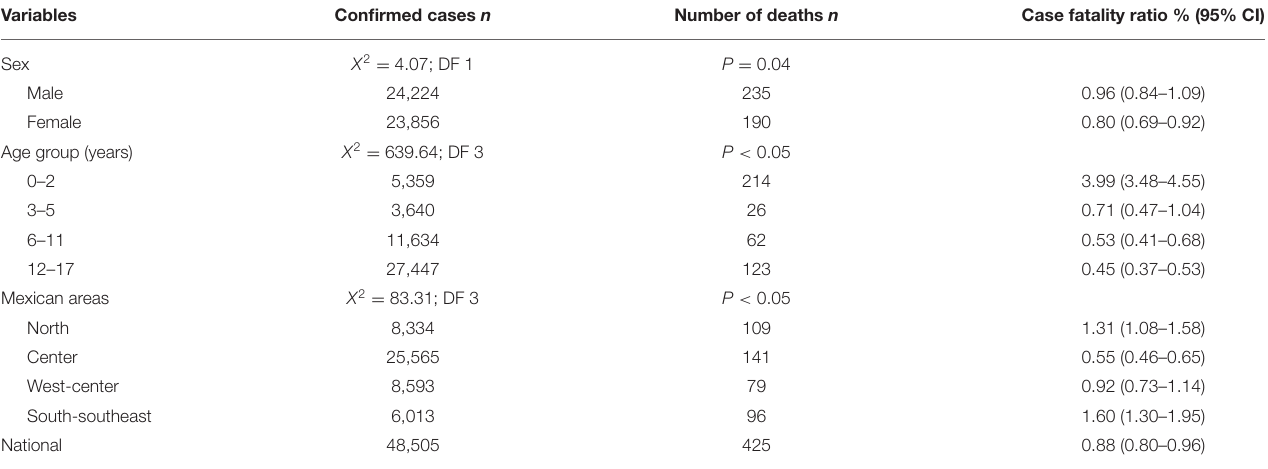
TABLE 1 | Distribution of case fatality ratio, by sex, age group, and area in Mexico.